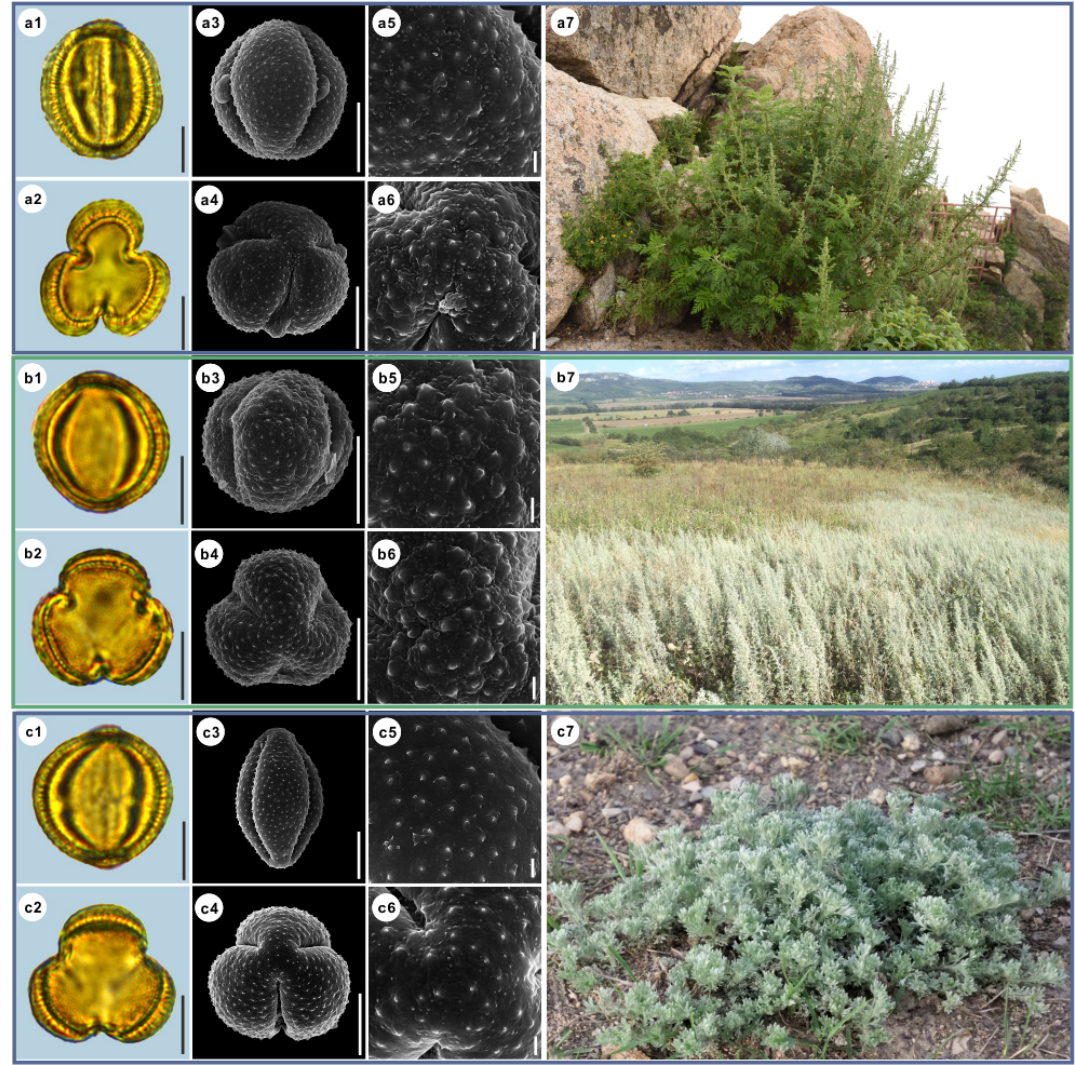
Figure 9. Pollen grains and the habitats of their source plants. (a) Artemisia stechmanniana ; (b) Artemisia pontica ; and (c) Artemisia frigida . Pollen grains in equatorial view under LM (a1, b1, c1) and SEM (a3, a5, b3, b5, c3, c5) , in polar view under LM (a2, b2, c2) and SEM (a4, a6, b4, b6, c4, c6) , along with the habitats of their source plants (a7 provided by © Bo-Han Jiao, b7 cited from https://www.inaturalist. org/photos/93438780, last access: 19 August 2022, by © Martin Pražák, c7 cited from https://www.inaturalist.org/photos/125022240, last access: 19 August 2022, by © Suzanne Dingwell ) . Scale bar in LM and SEM overview 10µm, and in SEM close-up